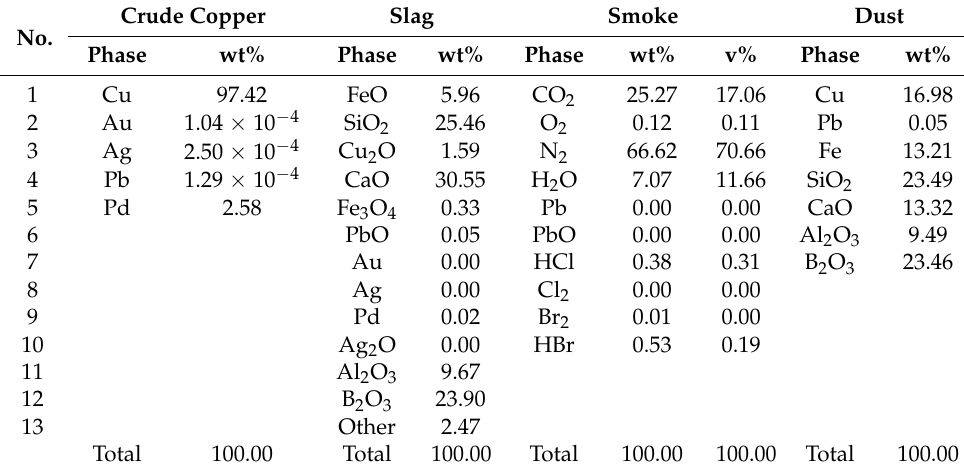
Table 3. The product contents of the NRT